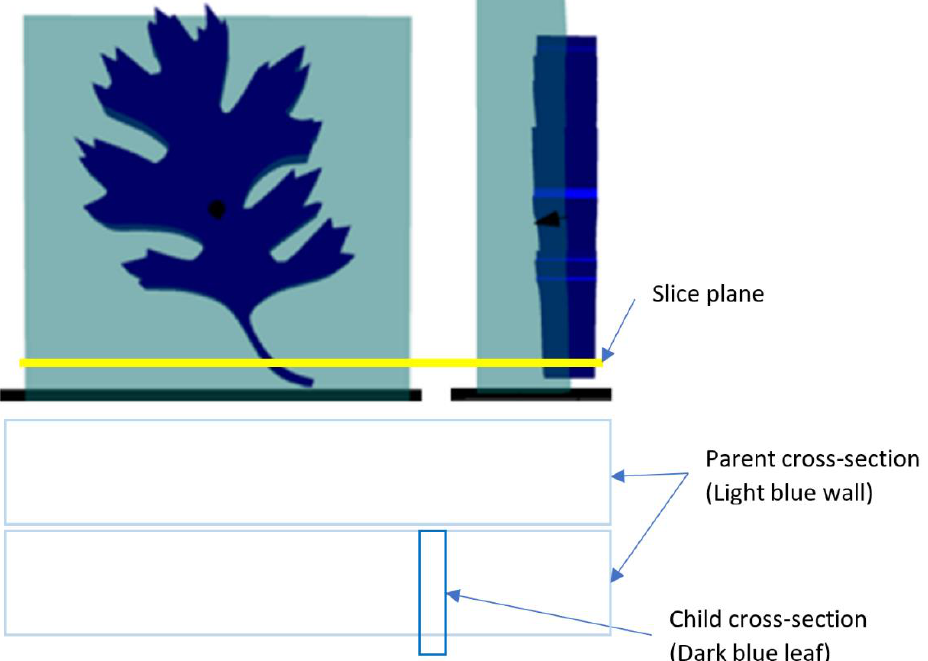
Figure 3. Example cross-section. Top : The yellow line represents the slicing plane. Bottom : The cross-section results in two rectangular areas for the wall and one smaller area for the leaf stem.